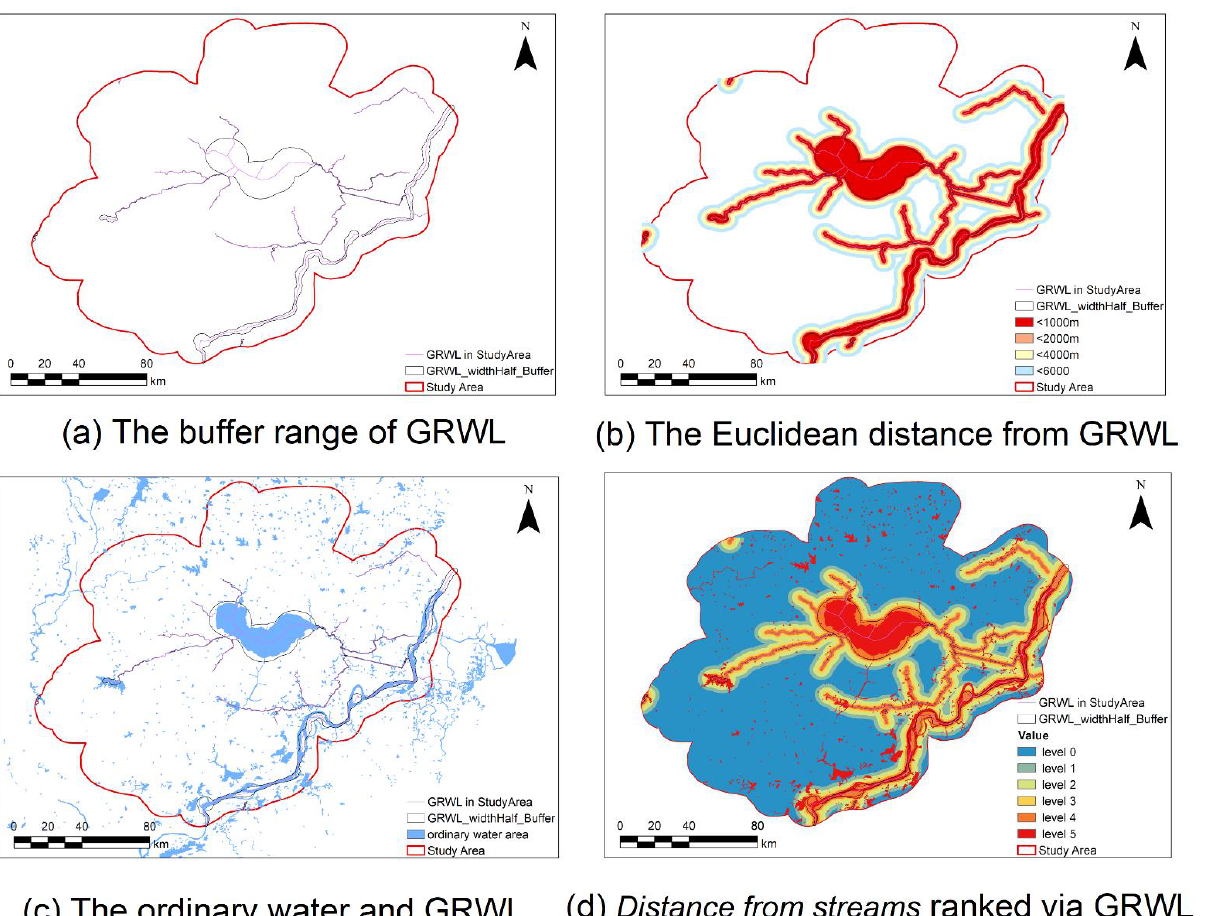
Figure 13. The GRWL distribution and the GRWL-based Distance from streams indicator in the study area. Figure ( a ) was the GRWL vectors and corresponding buffer results basing the attribute value of the width, figure ( b ) was the Euclidean distance from the GRWL buffer border, and figure ( c ) was the ordinary water bodies overlying the GRWL buffer layer and the ranked “ Distance from streams” indicator in figure ( d ) was derived by GRWL and normal water